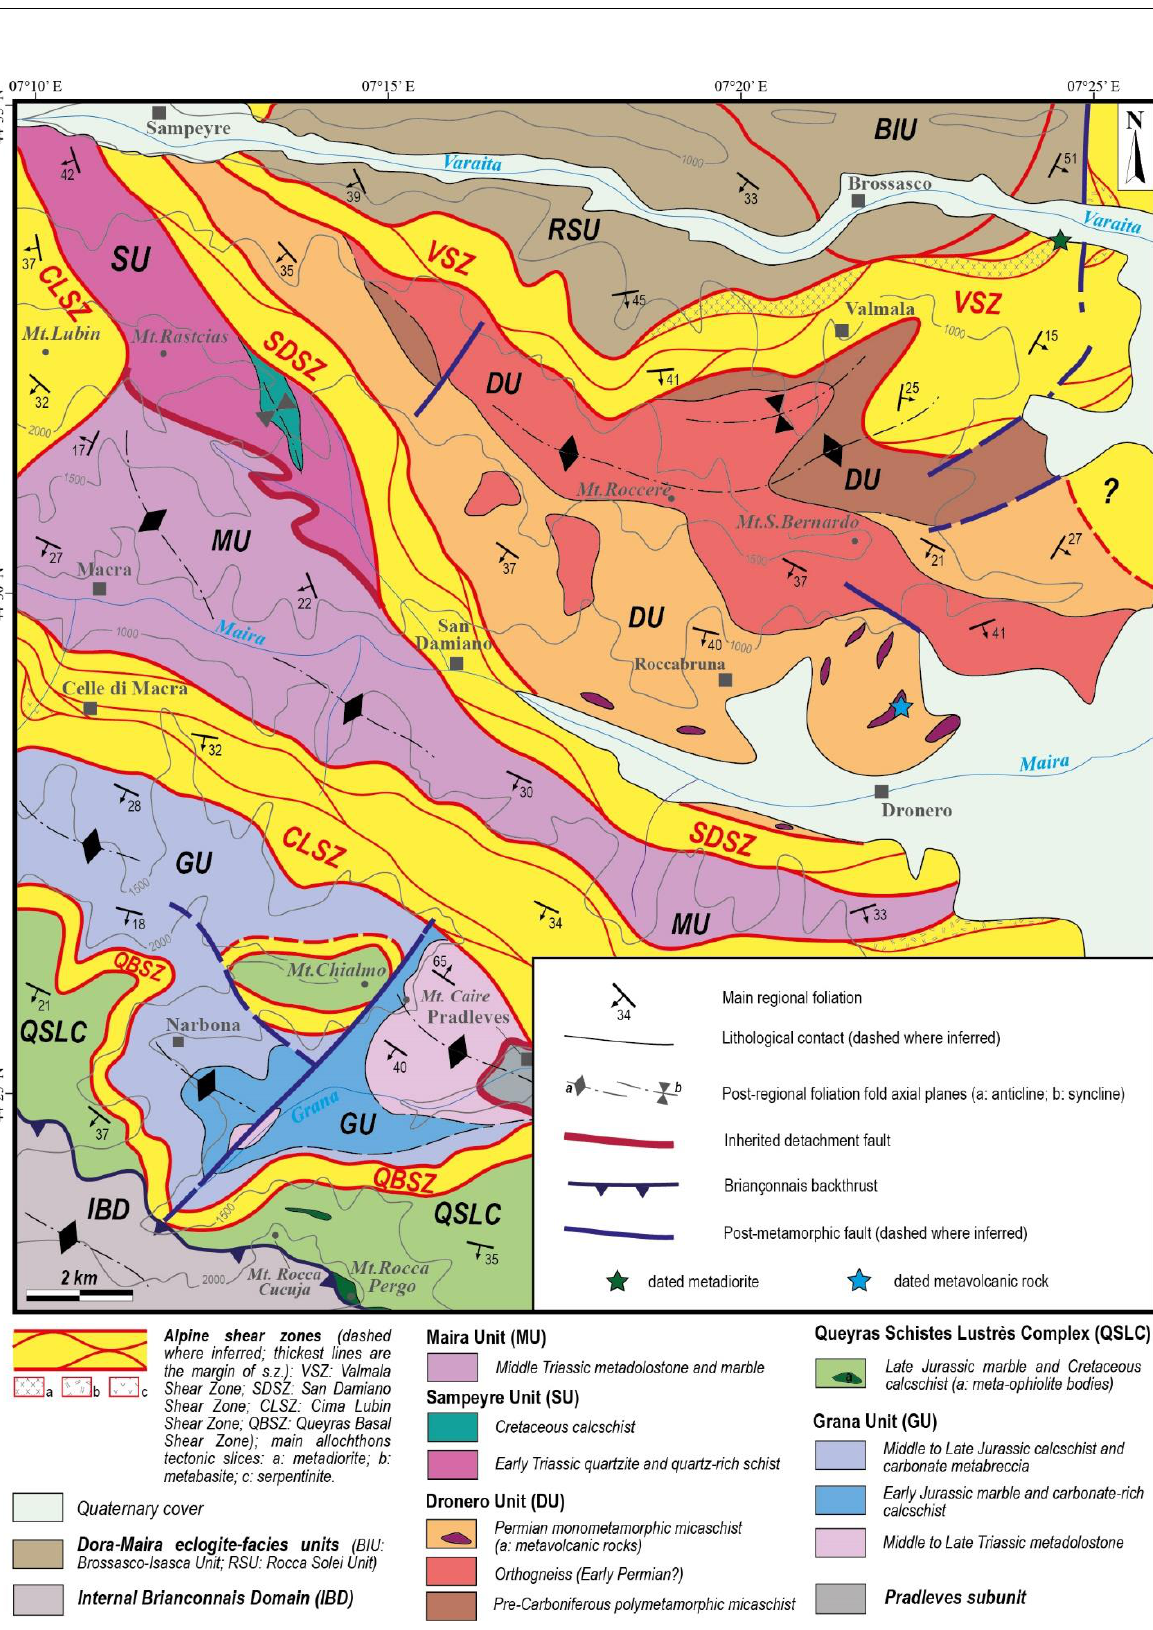
Figure 2. Geological map of the study area in the Western Alps, showing the spatial and tectonic relationships of tectonostratigraphic units.